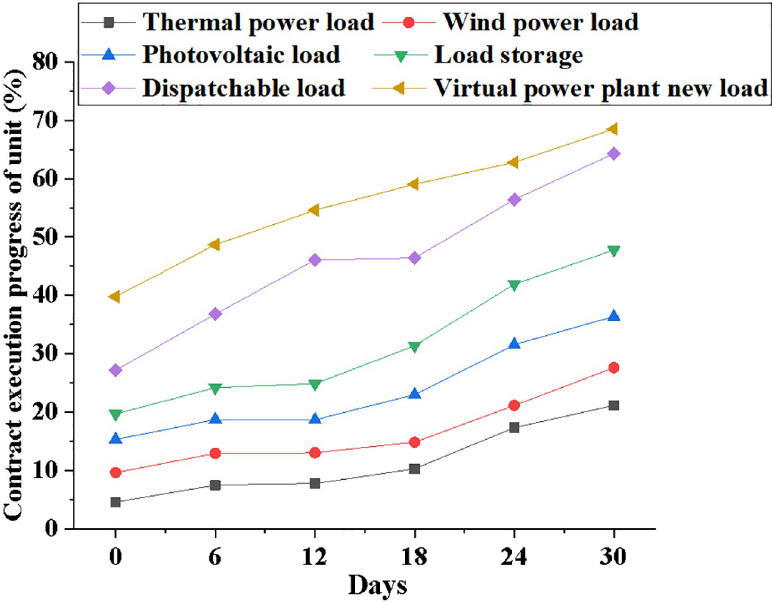
Fig 14. Curves of unit contract execution progress with time for systems with different power